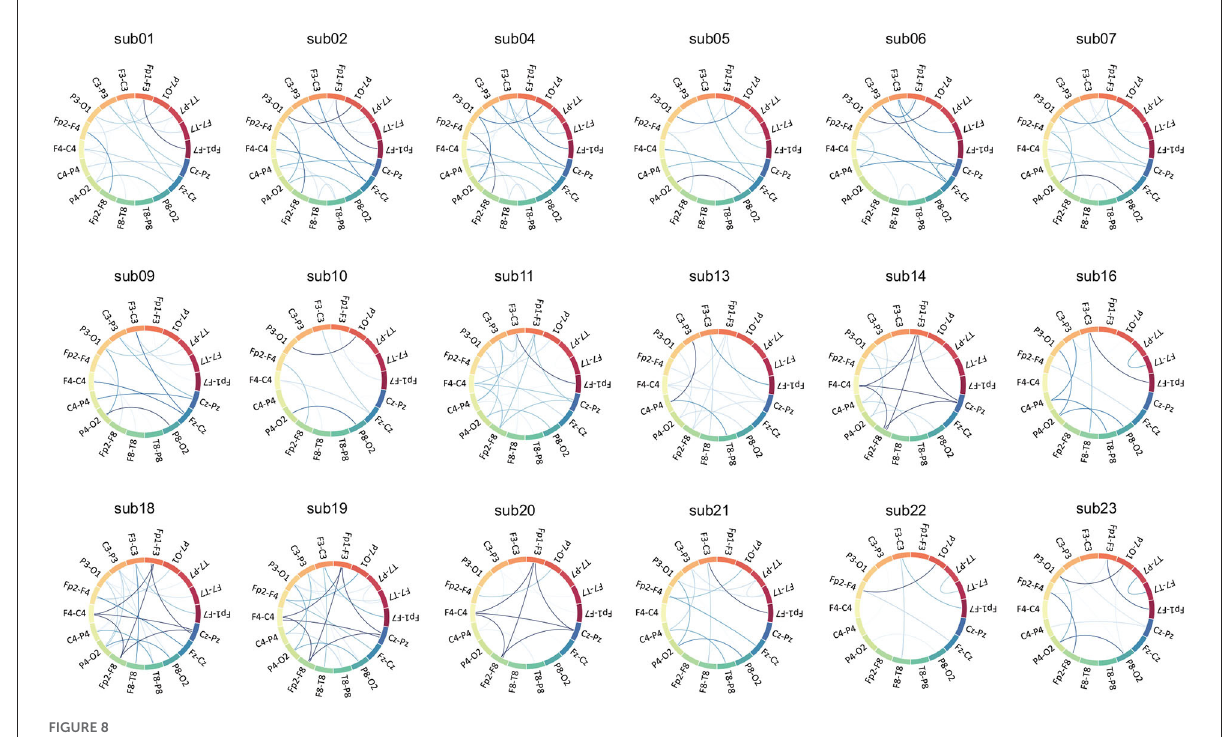
FIGURE8 Chord diagram of functional edge